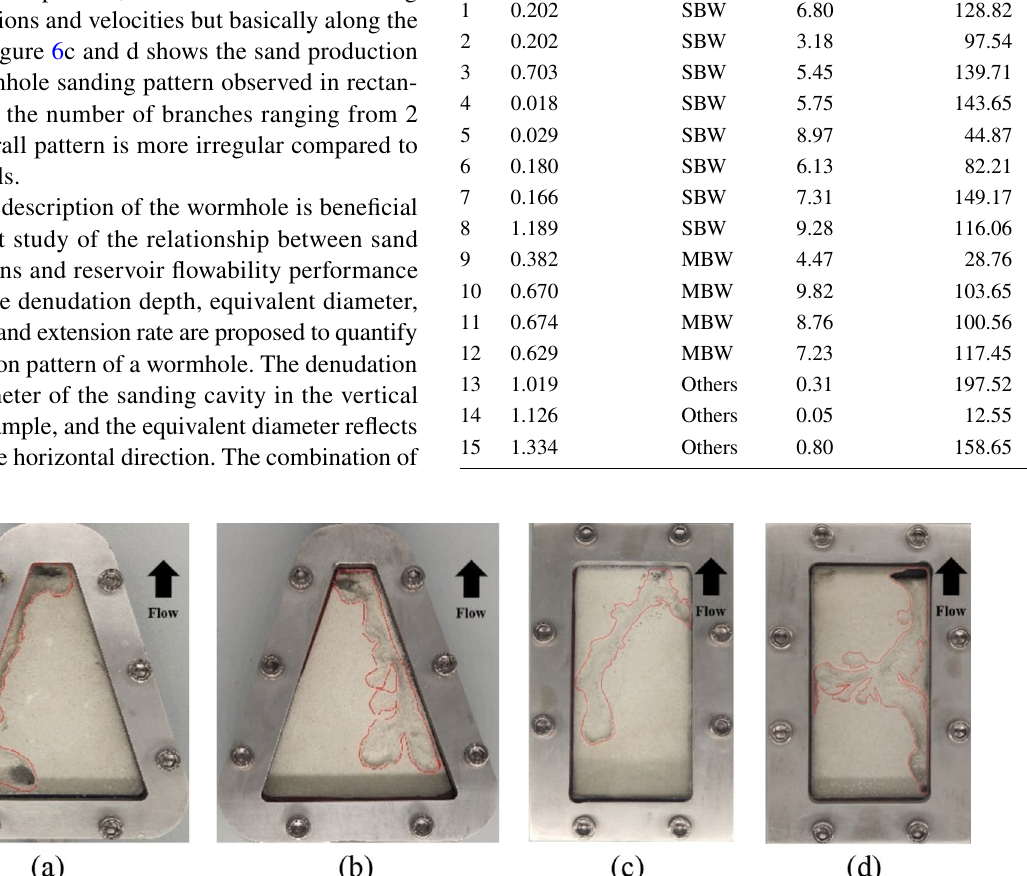
Table 2 The average aperture for each wormhole No. Uniaxial com- pressive